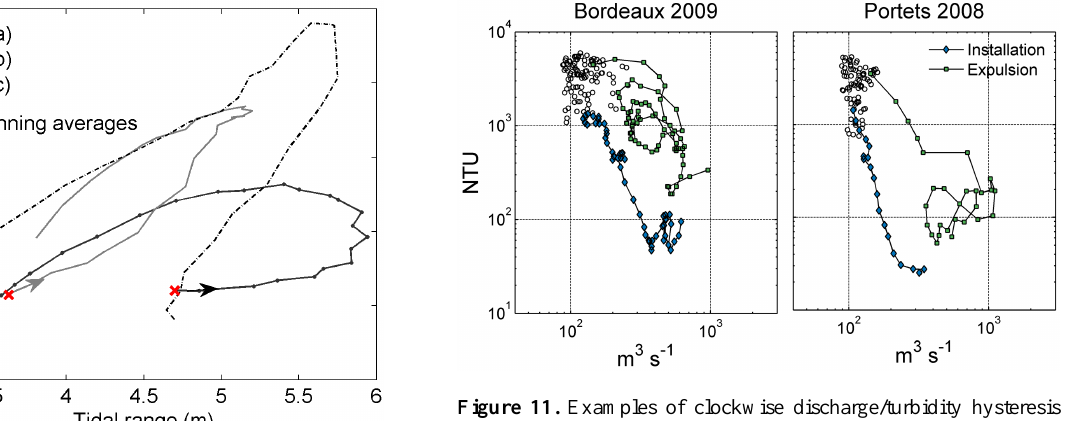
Figure 11. Examples of clockwise discharge/turbidity hysteresis curves during the transition periods of installation and expulsion of the TMZ (see these periods in Fig.